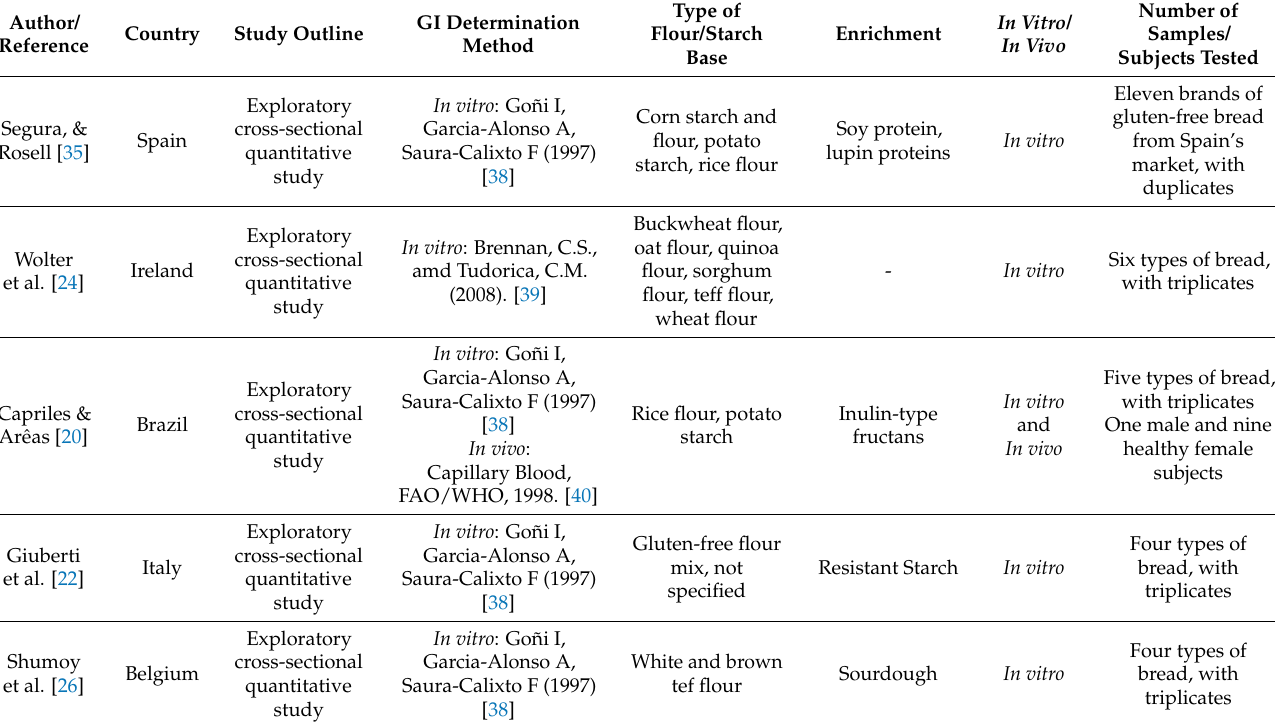
Table 1. Summary of descriptive characteristics and outcomes of interest in the included